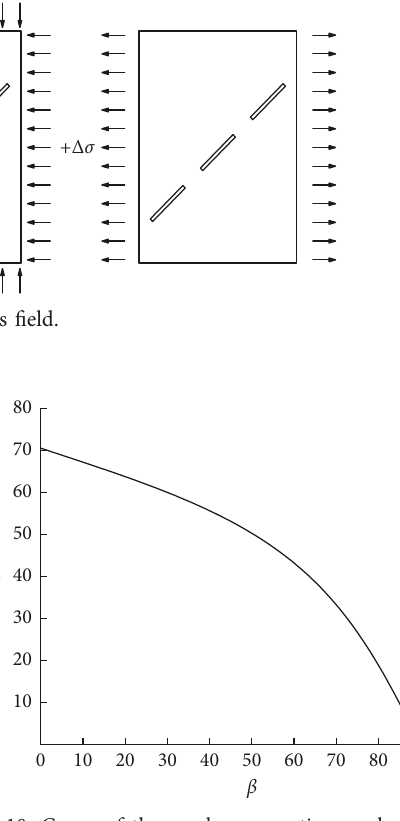
Figure 10: Curve of the crack propagation angle and crack dip